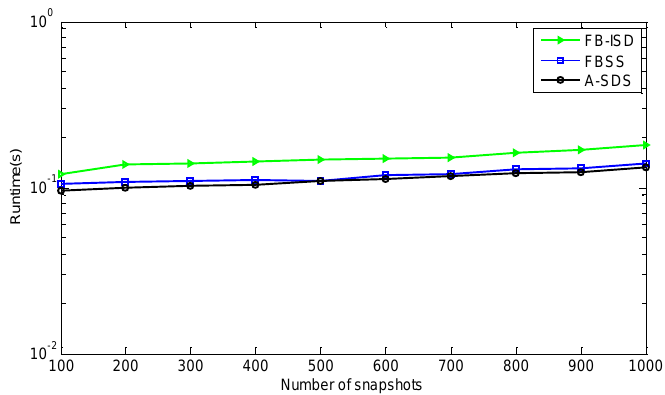
Figure 3. Comparison of runtime for relevant